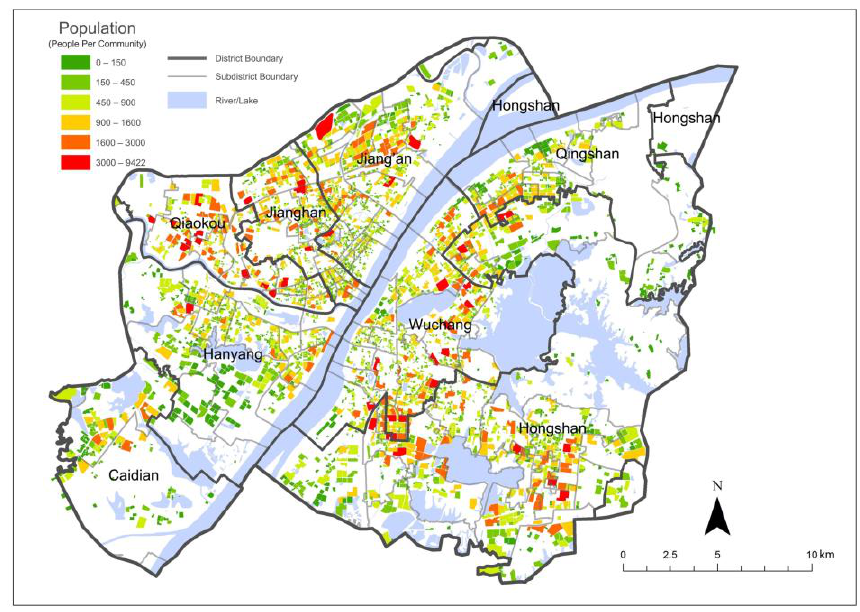
Figure 1. Population of communities (2010) and districts in the urban area of Wuhan [40].